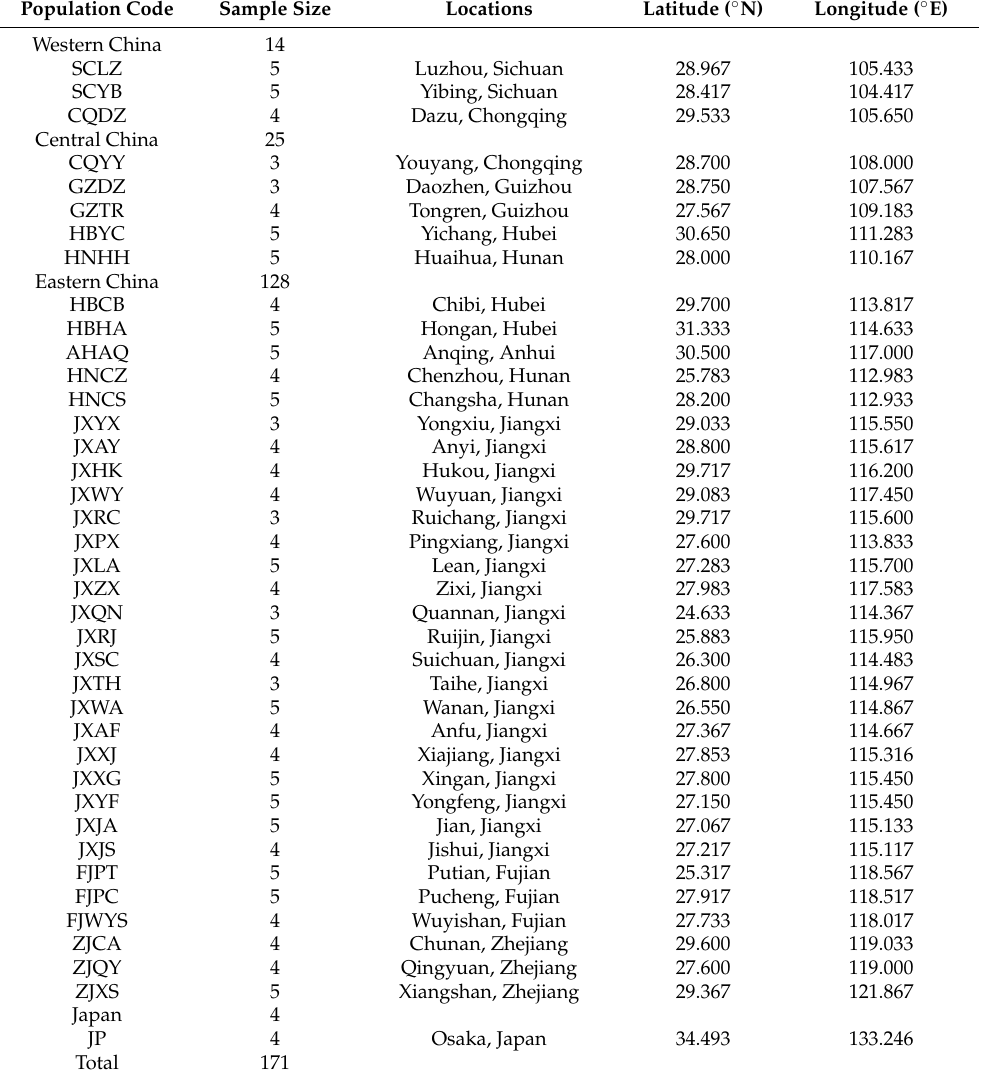
Table 1. Geographical locations, sample size and sample numbers of 40 C. camphora populations in China and